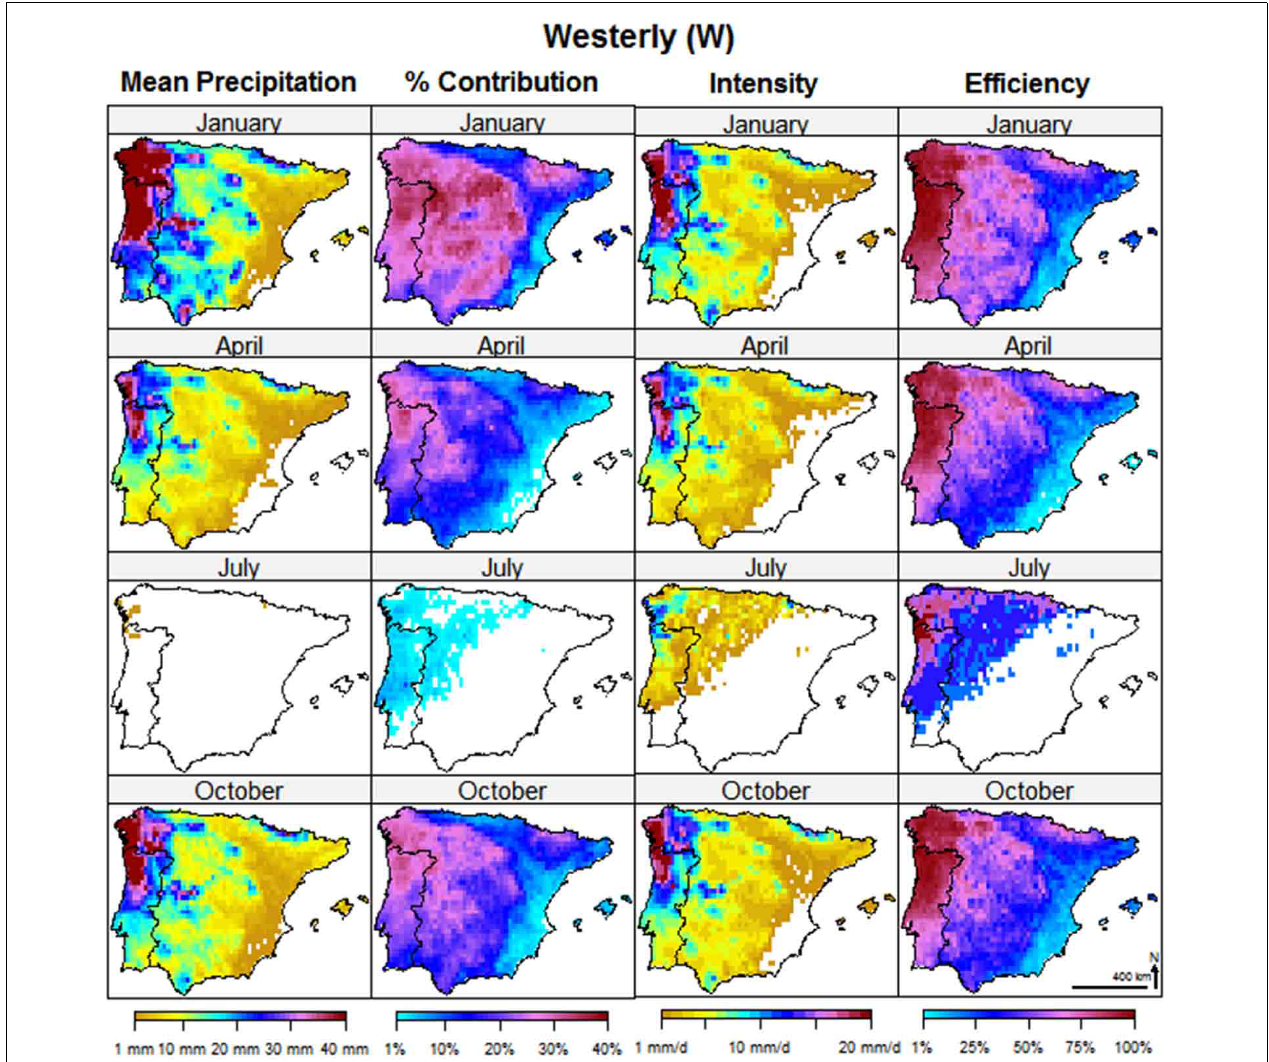
FIGURE 5 | Westerly (W) composite maps for the Mean Precipitation, Percentage Contribution, Precipitation Intensity, and Efficiency. The 4 months in the middle of each season are representative of each season: January for winter, April for spring, July for summer, and October for autumn.